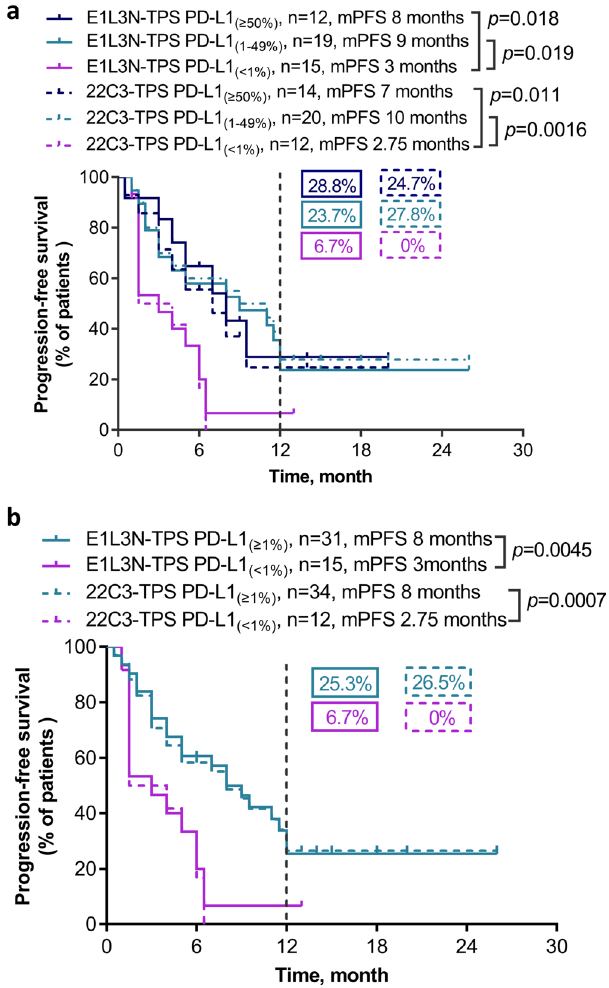
Fig. 5 Progression-free survival with fi rst-line pembrolizumab monotherapy was consistent between E1L3N and 22C3.